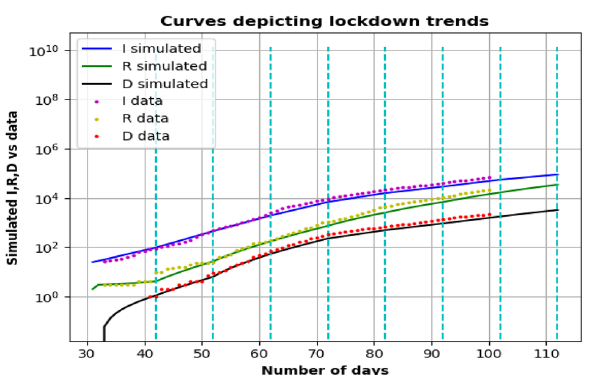
Figure 9. Simulating the prediction curves by using the best fit for every single interval obtained by dividing the time axis by the dashed cyan